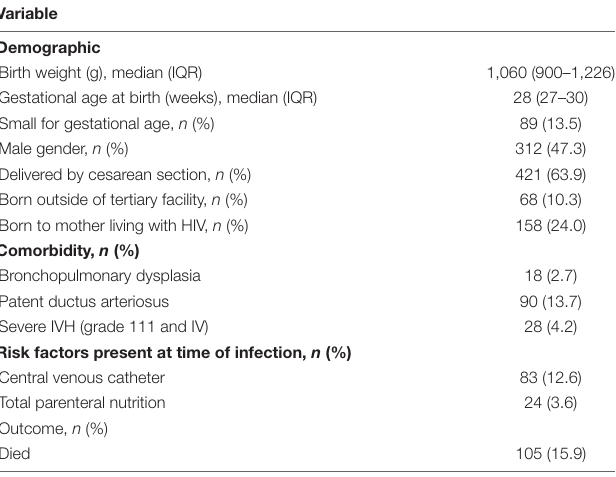
TABLE 2 | Baseline characteristics of neonates included in this study ( n = 658).